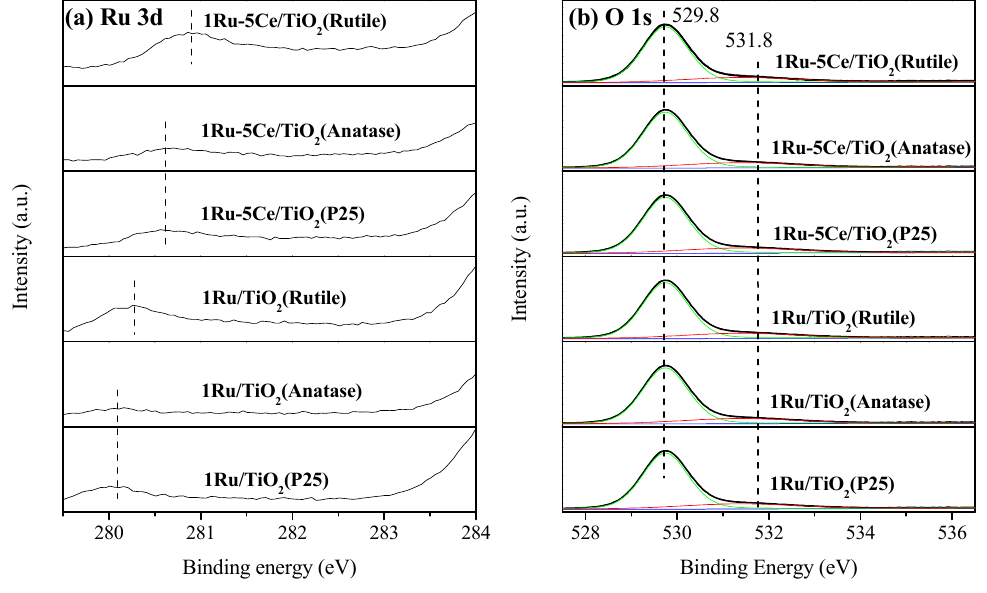
Figure 7. XPS spectra of Ru 3d ( a ) and O 1s ( b ) for Ru ‐ based catalysts. Table 1. XPS data of 1Ru/TiO 2 and 1Ru ‐ 5Ce/TiO 2 . Catalysts Ru (at. %)